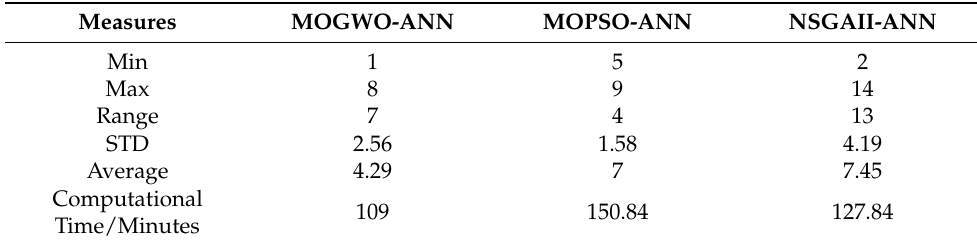
Table 7. Results of the statistical analysis on the number of selected measurements.